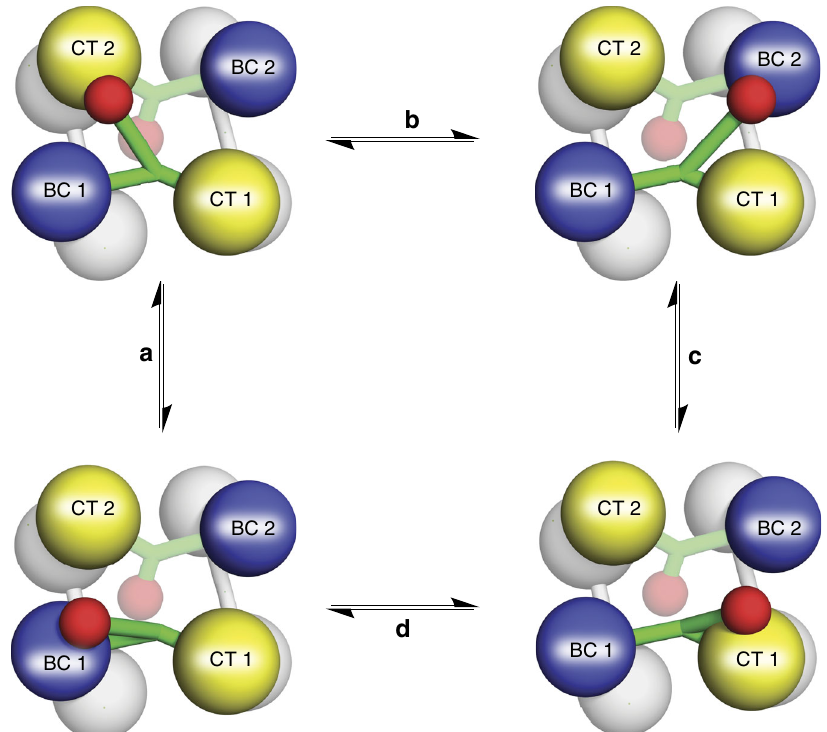
Fig. 2 BCCP translocation pathways in PC. The BCCP domain is theoretically capable of four catalytically productive translocation pathways between the individual active sites of PC. Subunits 1 and 2 from the upper layer are colored according to their individual domains, while the lower layer is colored in grey for clarity. The four translocation pathways ( a – d ) are shown for the BCCP domain (colored in red) from subunit 1. For clarity, the BCCP domain from subunit 2 is displayed as partially transparent, but it is also capable of adopting these same four translocation